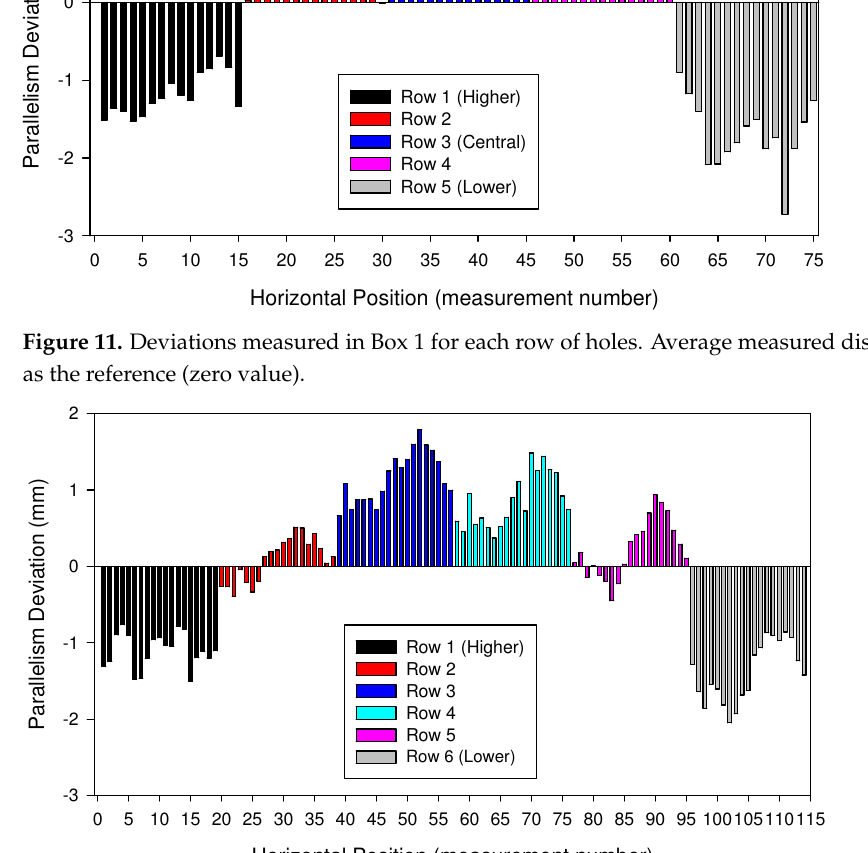
Figure 12. Deviations measured in Box 2 for each row of holes. Average measured distance is taken as the reference (zero